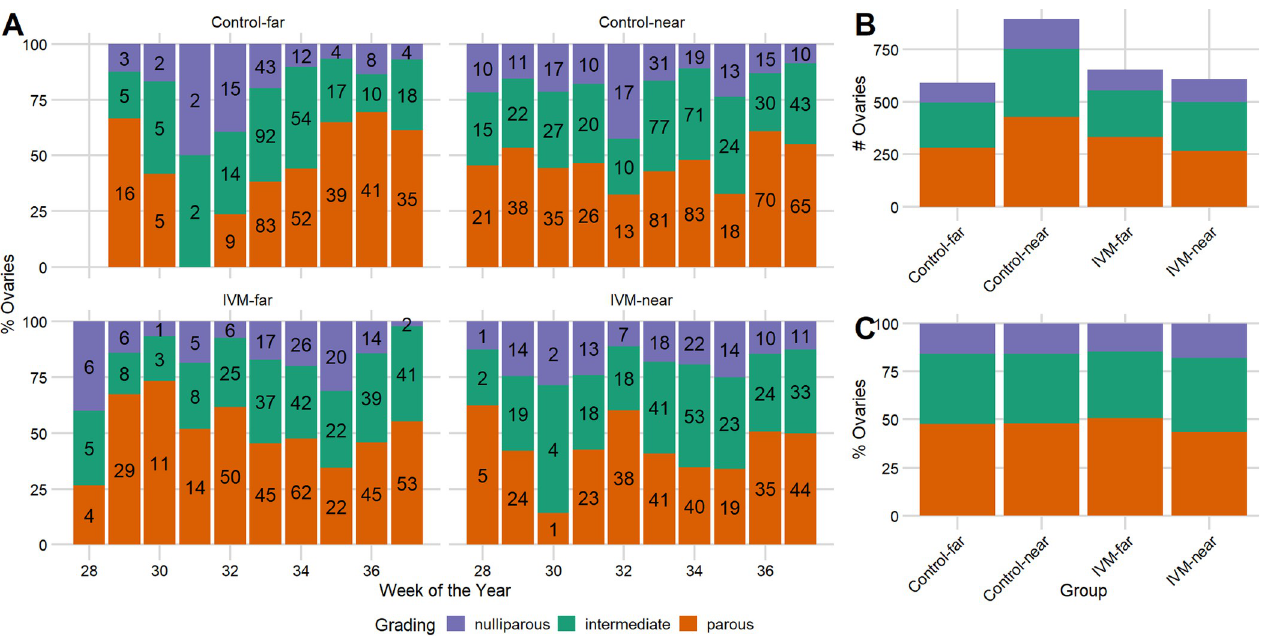
Fig 6. Parity rates in Culex tarsalis around ivermectin (IVM)-treated and untreated chicken flocks. Parity grading during the West Nile virus (WNV) season near ( � 10m) and far (~150m) from treated and untreated flocks for (A) individual weeks and (B-C) collapsed by group for weeks with observations in each group (weeks 29–37). Number of ovaries in each category by week indicated in bars in